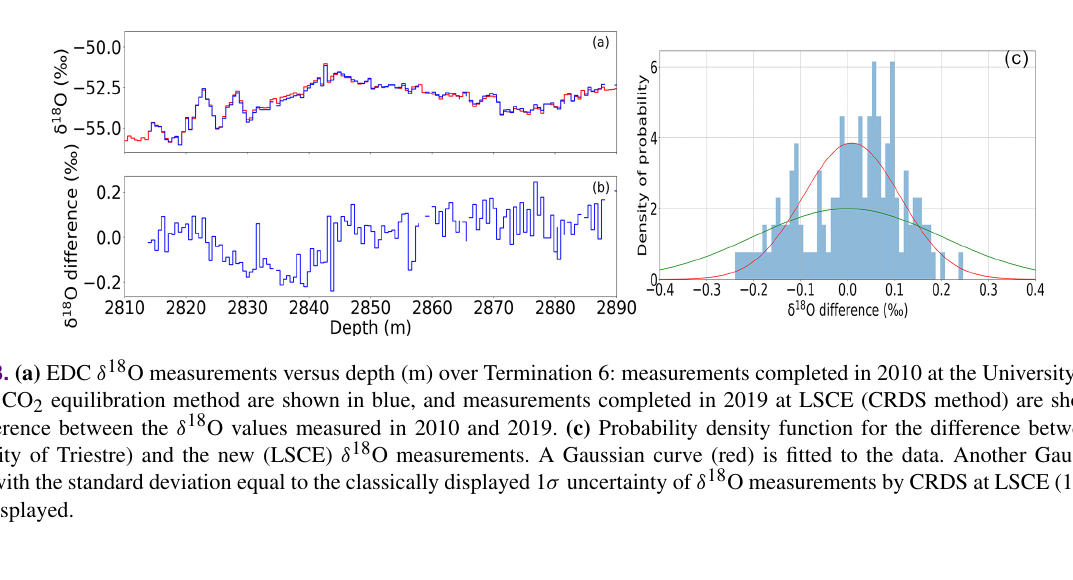
Figure 2. (a) EDC δ D measurements versus depth (m) over Termination 2: measurements completed in 2010 at LSCE (uranium reduction method; Pol et al., 2014) are shown in blue, and measurements completed in 2019 at LSCE (CRDS method) are shown in red. (b) Difference between the δ D values measured in 2010 and 2019. (c) Probability density function for the difference between the first (uranium reduction) and the new (CRDS) δ D measurements. A Gaussian curve (red) is fitted to the data. Another Gaussian curve (green) with the standard deviation equal to the classically displayed 1 σ uncertainty of δ D measurements with the CRDS method at LSCE (1 σ = 0.7‰) is also displayed.